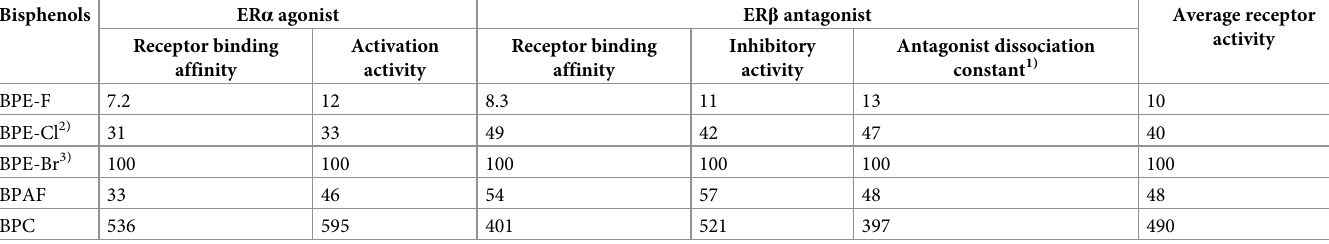
Table 3. Specific activities of halogen-containing bisphenols for ER α and ER β